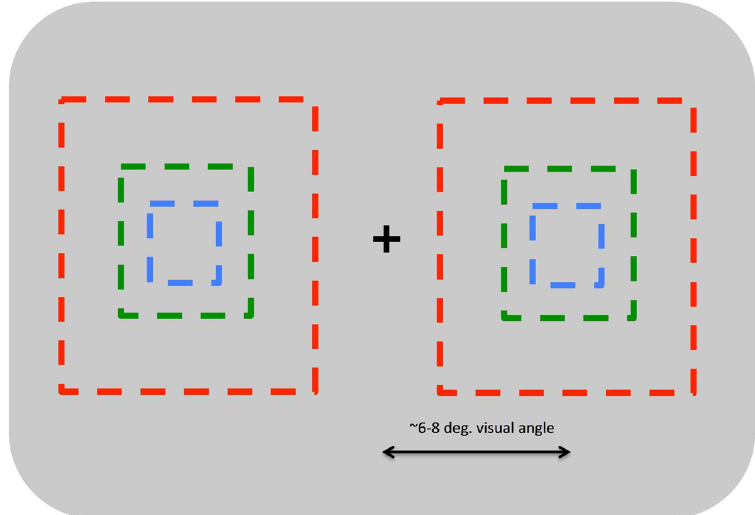
Figure 5. A schematic view of how we manipulated image eccentricity in Experiment 3B. Observers rated FFDE sequences either at the original size (green rectangle), half-size (blue rectangle) or double-size (red rectangle). The eccentricity of the image was fixed at the same distance as Experiments 1 and